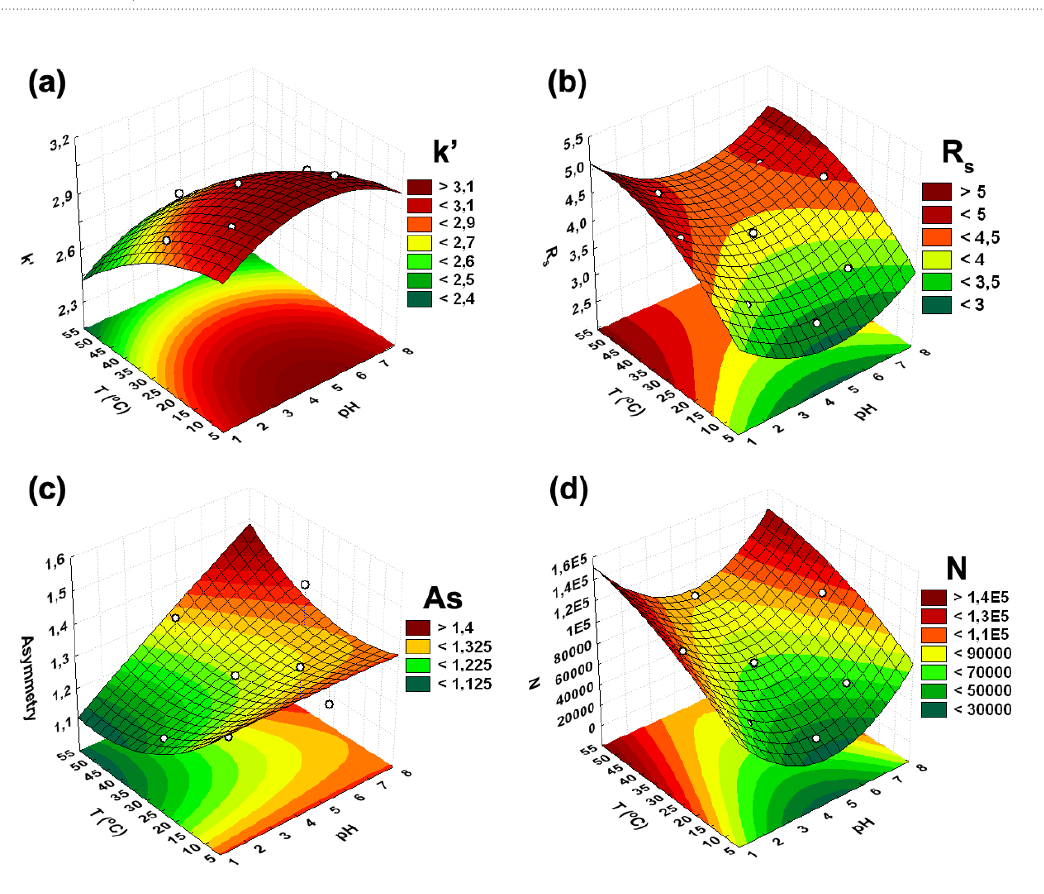
Figure 4. Response surface graph functions of pH of the mobile phase and column temperature (a) k’, (b) R